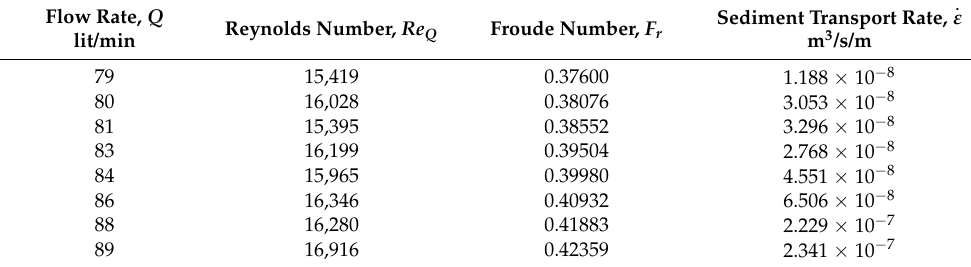
Table 1. Experimental